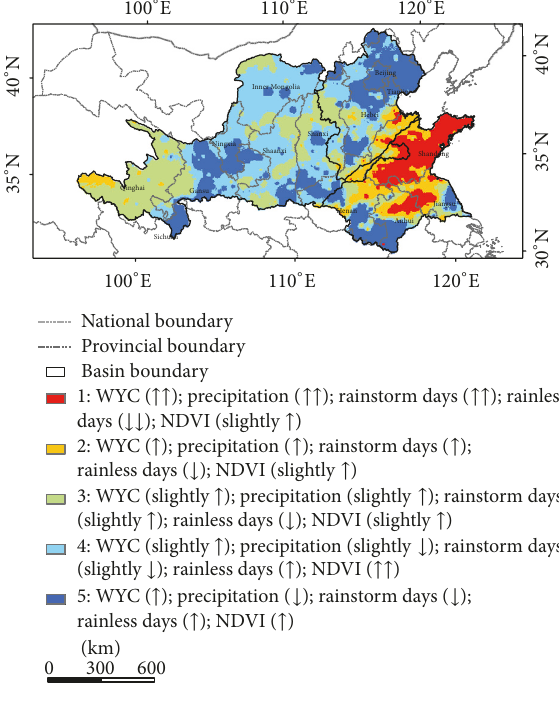
Figure 12: Cluster